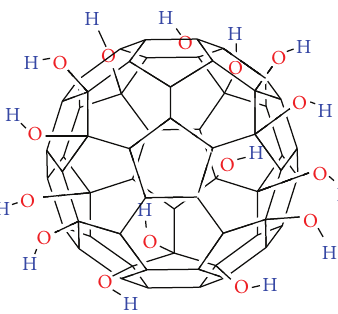
Figure 1: The structure of